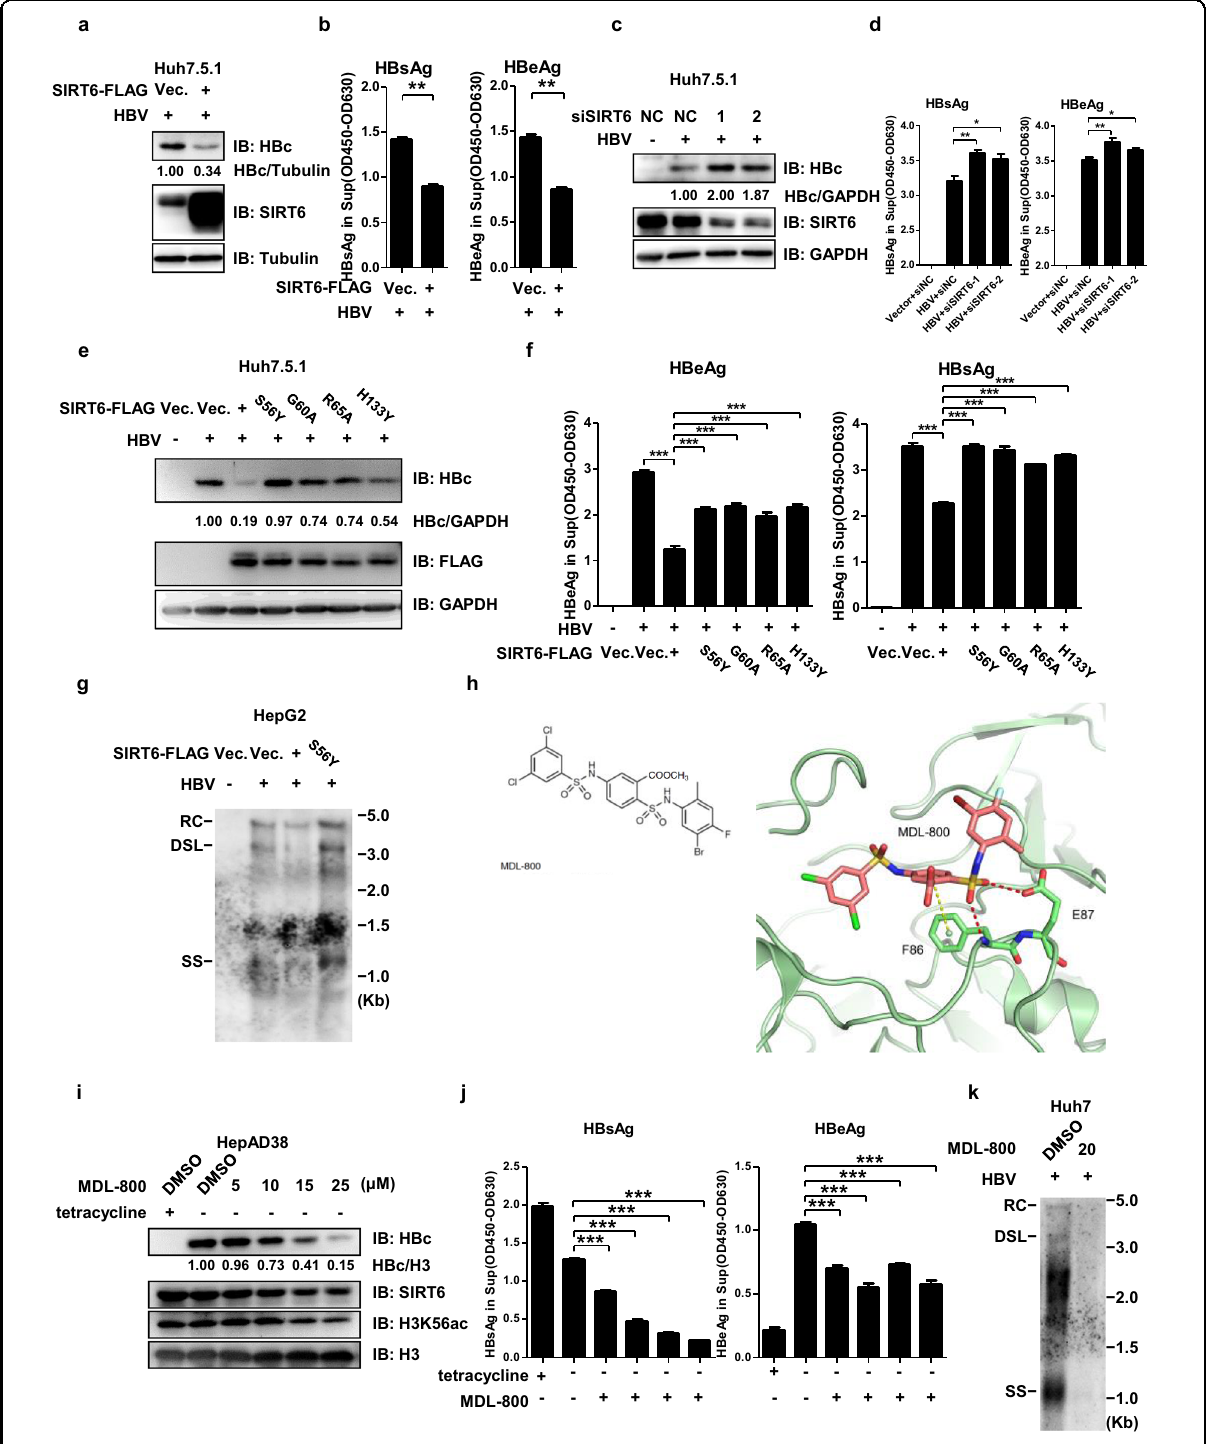
Fig. 4 Identi fi cation of SIRT6 as a host virus-restricting factor against HBV. a , b Introduction of Sirt6 suppressed the expression of HBcAg ( a ) and HBsAg and HBeAg ( b ) antigens in Huh7.5.1 cells. c , d Knocking-down endogenous Sirt6 promoted the expression of HBcAg ( c ) and HBsAg and HBeAg ( d ) antigens in Huh7.5.1 cells. e , f Effect of SIRT6 enzymatic mutants on HBcAg ( e ) and HBsAg and HBeAg ( f ) expression in huh7.5.1 cells. g The effect of SIRT6 wild type or enzymatic de fi cient mutant on HBV genome replication was measured via southern blotting in HepG2 cells. h The chemical formula and a close-up view of MDL-800 in complex with 2 ′ -O-acyl-ADP ribose (2 ′ -O-acyl-ADPR) motif of human SIRT6 (X-ray structure, PDB number 5Y2F). i , j ELISA shows that MDL800 suppressed the expression of HBcAg ( i ) and HBsAg and HBeAg ( j ) antigens in dose-dependent manner in Tet-controlled HBV in HepAD38 cells. k MDL-800 treatment signi fi cantly suppressed HBV genome replication intermediates in Huh7 cells. RC relaxed circular, DNA DSL double strand linear DNA, SS single strand DNA. For ELISA, for panel b, n = 2; for others, n = 3. * P < 0.05, ** P < 0.01, *** P <